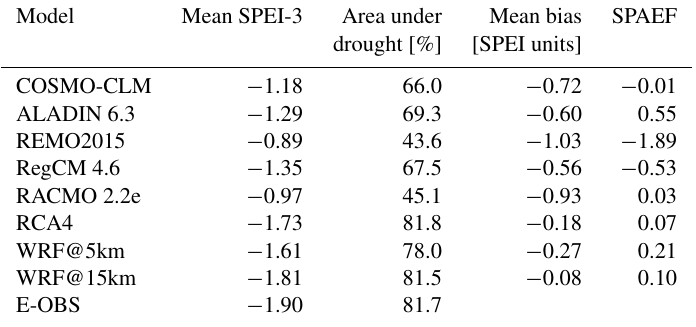
Table 5. Drought event August 2003 – SPEI-3 metrics including the spatial efficiency (SPAEF) scores for the spatial agreement between each RCM and E-OBS as reference.